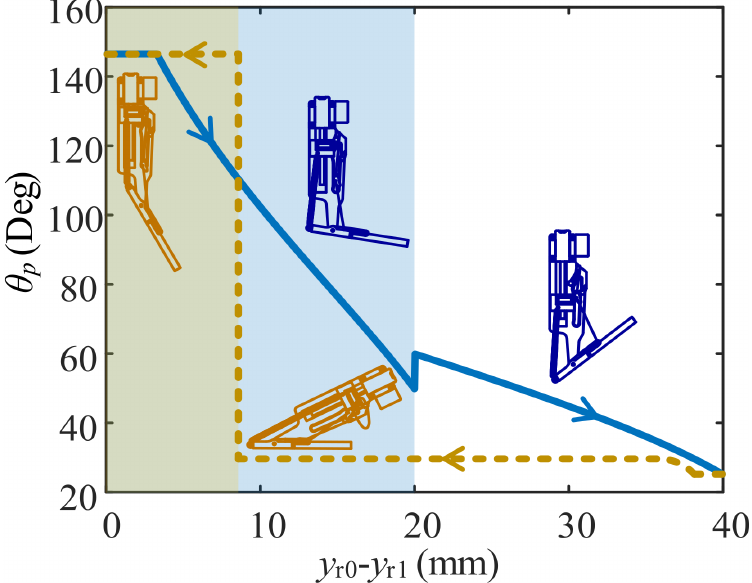
Figure 5. Curve of displacement of RS ( y r0 − y r1 ) vs. angle between pole and motor output shaft ( θ p ). The thick blue curve is the resetting process in which the RS moves downward. The area with a colored background is for θ p > θ c , and that with the white background is for θ p < θ c . The yellow dotted curve is the launching process in which the RS moves upward. The area with the yellow background is for the post-launch period, and the rest is for the pre-launch